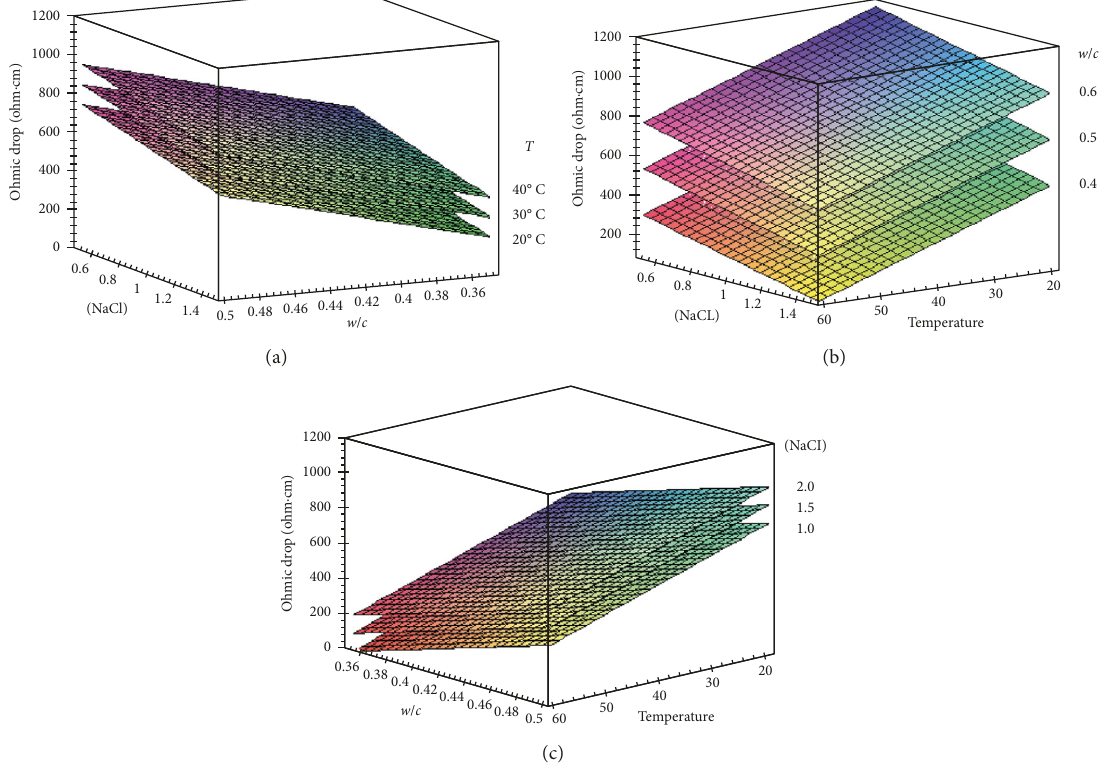
Figure 10: Calculated ohmic drop from (9): influence chart (response surface). (a) Constant curing temperature of 20 ° C, 30 ° C, and 40 ° C, (b) constant water-cement ratio of 0.40, 0.50, and 0.60, and (c) constant chloride content of 1 M, 1.5M, and